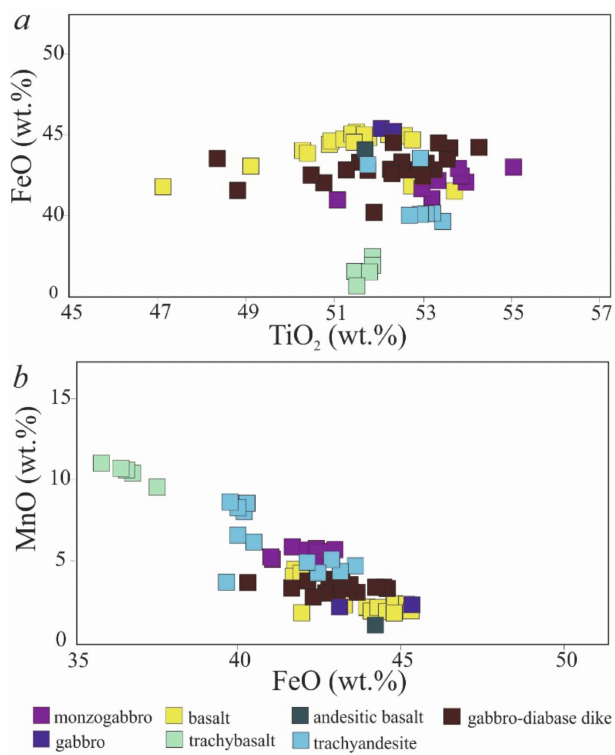
Figure 12. The relationship of ( a ) TiO 2 / FeO and ( b ) FeO / MnO among